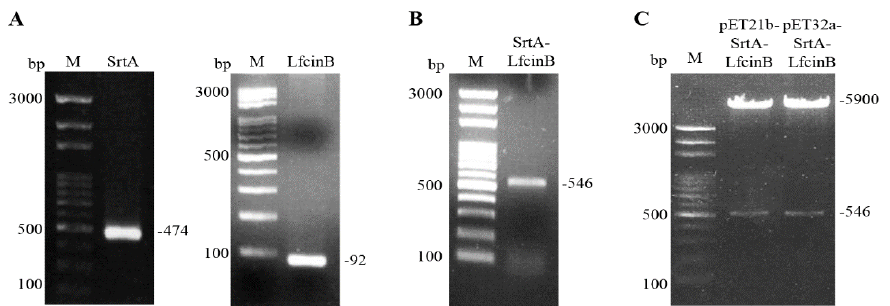
Figure 2. Amplification of the SrtA and LfcinB fusion gene and construction of pET32a ‐ SrtA ‐ LfcinB and pET21b ‐ SrtA ‐ LfcinB plasmids. ( A )The SrtA gene with a SrtA recognition cuting site at the 3 ′ end and a BamHI restriction site at the 5 ′ end was amplified by PCR from Staphylococcus aureus. The expected size of the PCR products is 474 bp in length (left panel). ( B ) The LfcinB gene with a SrtA recognition cutting site at the 5 ′ end and a BamHI restriction site at the 3 ′ end was amplified by overlapping PCR. The expected size of the PCR products is 92 bp in length (right panel). ( B ) LfcinB and SrtA DNA fragments were used as templates and the SrtA ‐ LfcinB fusion gene with a 5 ′ end NdeI and 3 ′ end SalI restriction sites was amplified by overlapping PCR. The PCR product (546 bp) was amplified. ( C ) pET32a ‐ SrtA ‐ LfcinB and pET21b ‐ SrtA ‐ LfcinB were digested with NdeI and SalI and the expected fragment (546 bp) was obtained. Lane M: DNA marker.